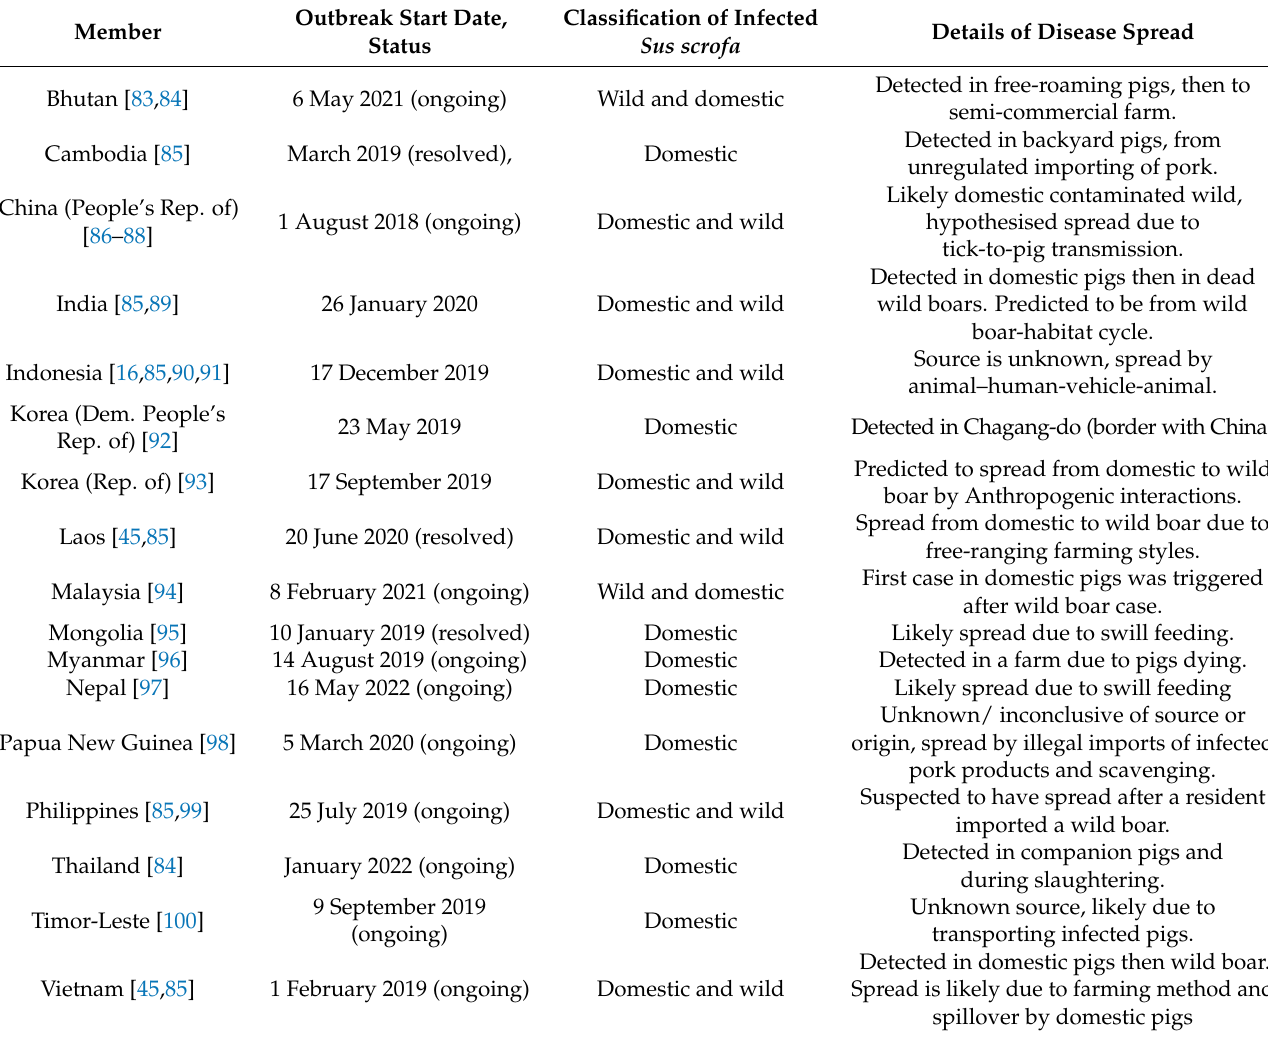
Table 4. Reported outbreaks of African swine fever by World Organisation for Animal Health members in Asia-Pacific from 2018 to present (7 August